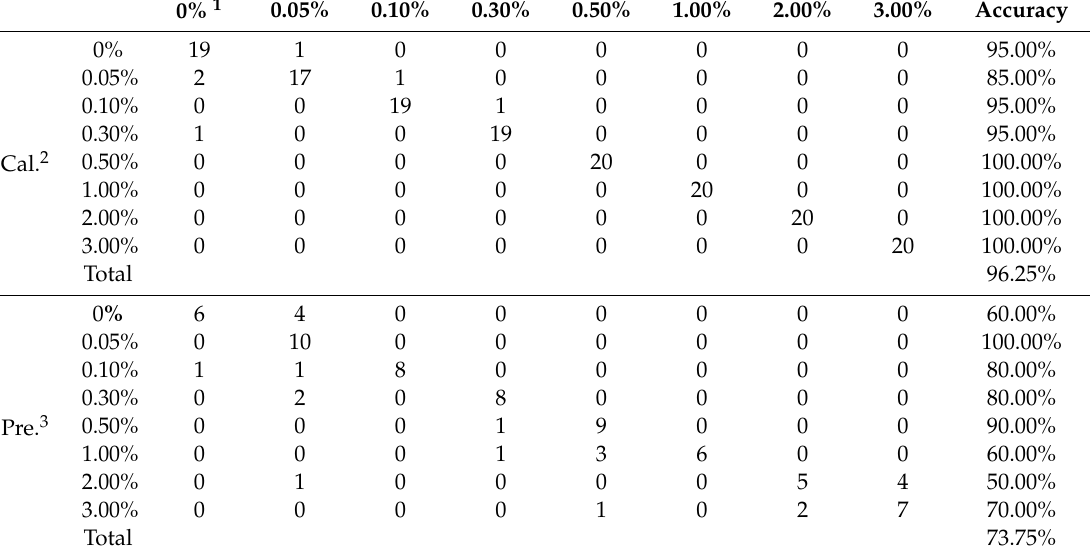
Table 1. Confusion matrix of SVM model based on full spectra for classification the sulfur dioxide residues on the surface of fresh-cut potato slices immersed in di ff erent concentrations of sodium pyrosulfite solution by the portable NIR